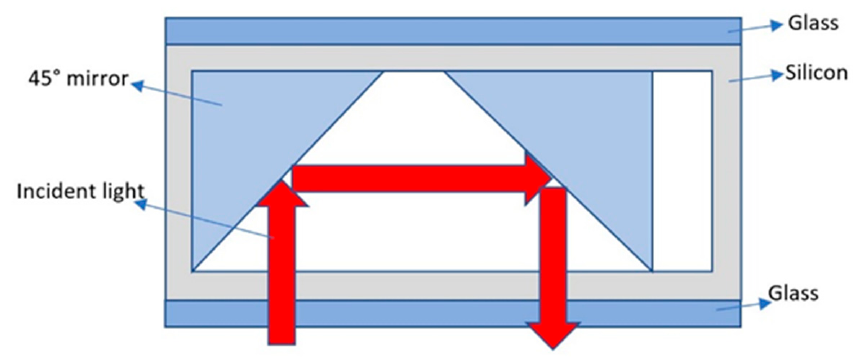
Figure 11. Concept and schematic view of the reflection-type vapor cell.